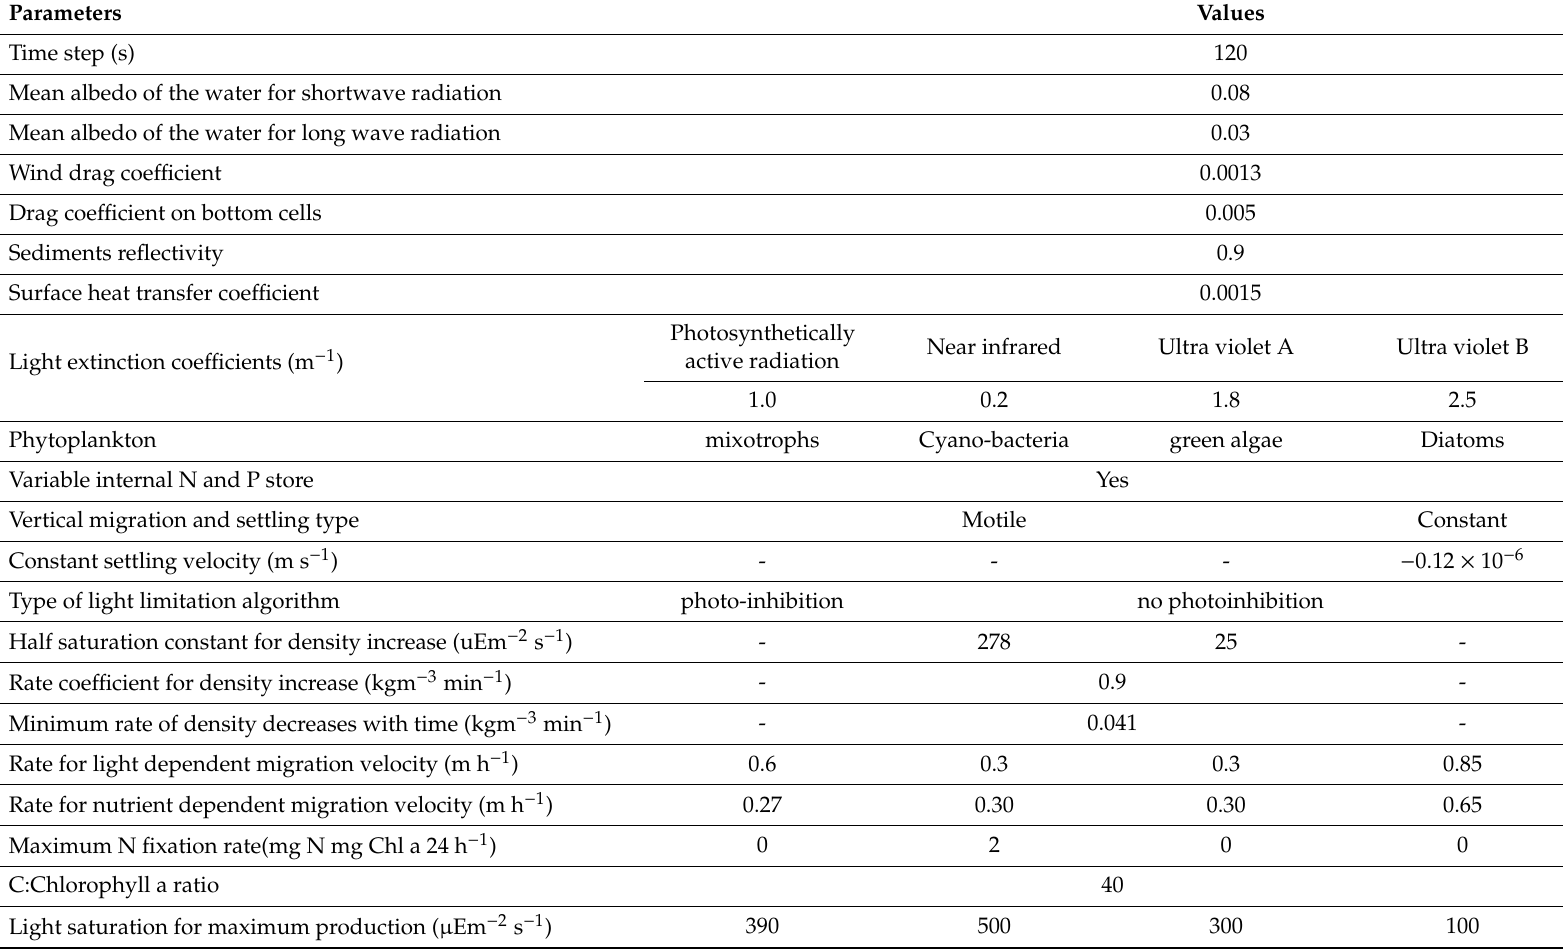
Table 3. Configuration of the AEM3D model for the Paprocany